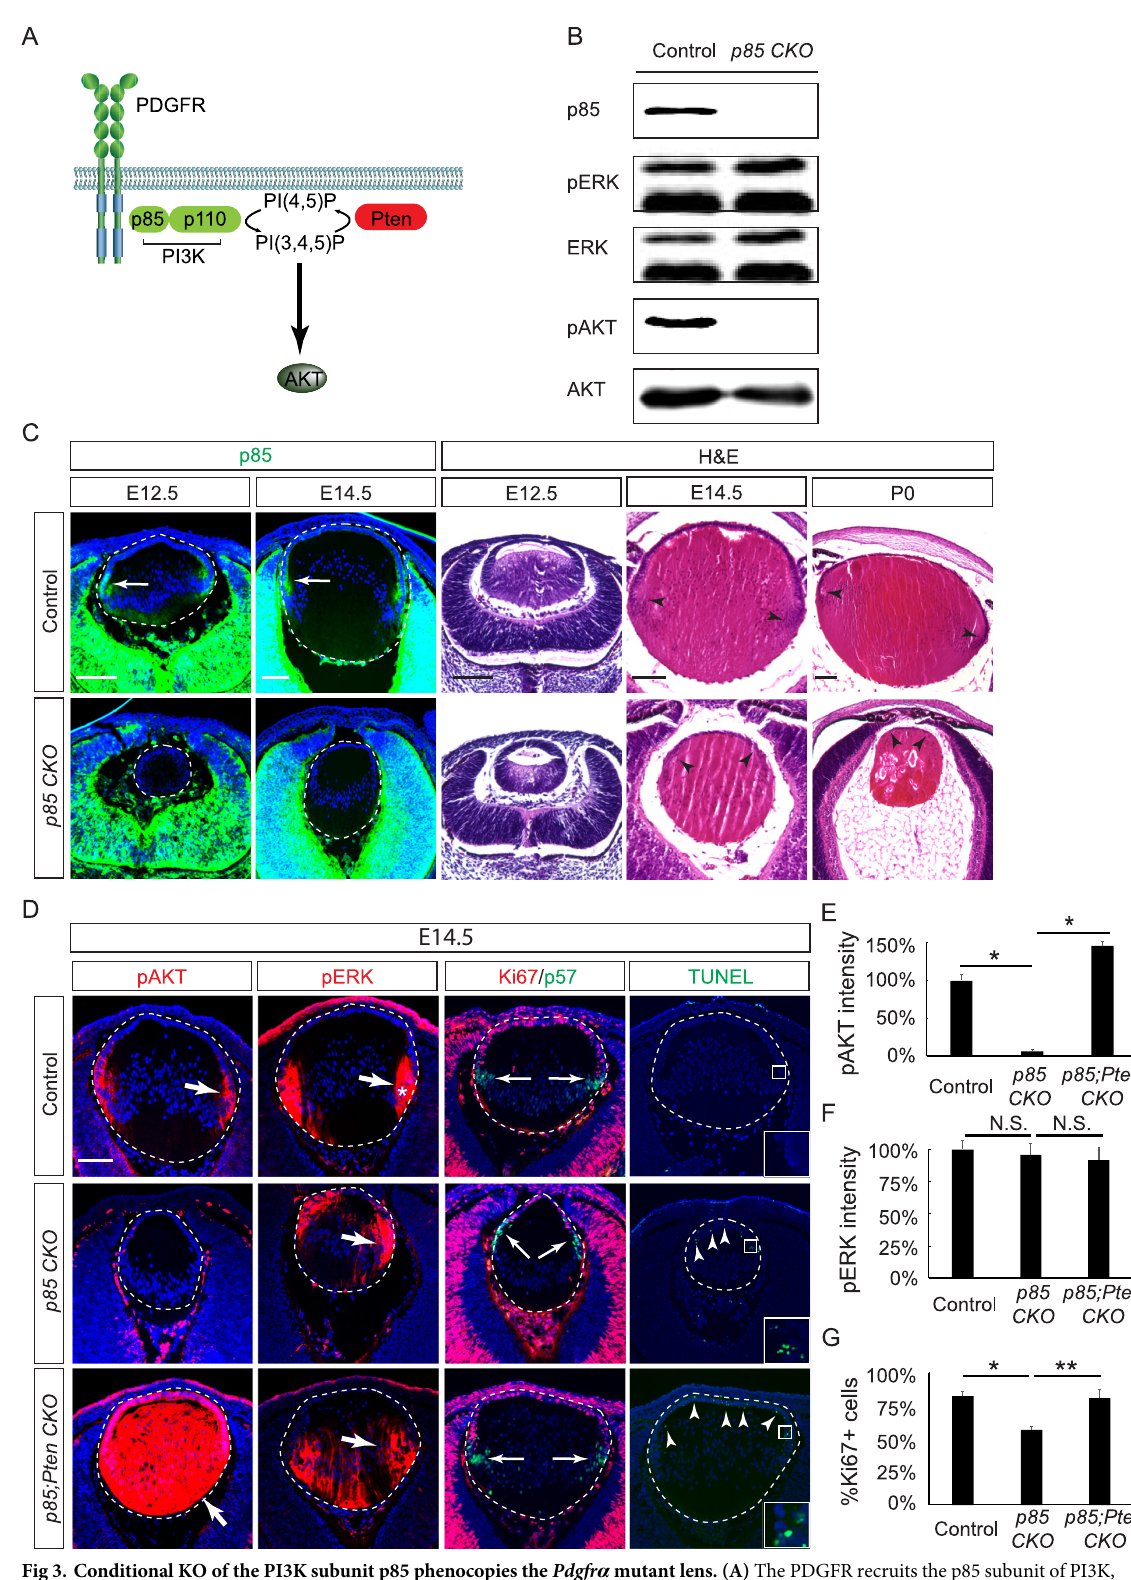
Fig 3. Conditional KO of the PI3K subunit p85 phenocopies the Pdgfr α mutant lens. (A) The PDGFR recruits the p85 subunit of PI3K, which activates AKT signaling by converting PI-4,5-P to PI-3,4,5-P. This reaction can be reserved by Pten to inhibit AKT signaling. (B)